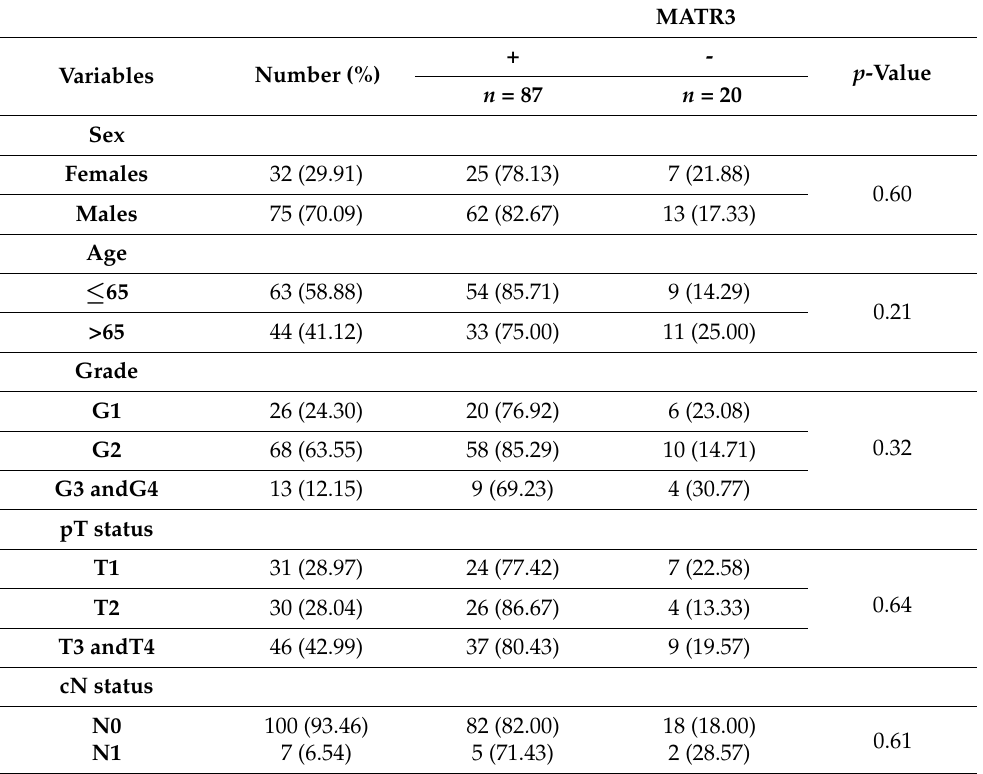
Table 1. MATR3 protein expression and its relationship with clinicopathological features of clear cell renal cell carcinoma (ccRCC) patients in our cohort. “-“ indicates low expression; “+” indicates high expression. MATR3